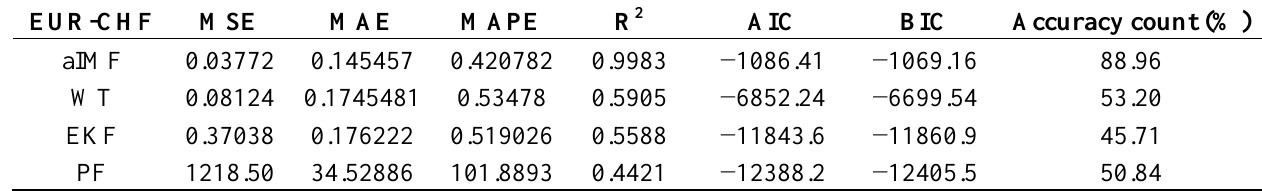
Table 8. Performance measurements of original dataset, EUR-CHF, using noise distribution at 10% with 10 Hz and 20% amplitude of the original signals’.